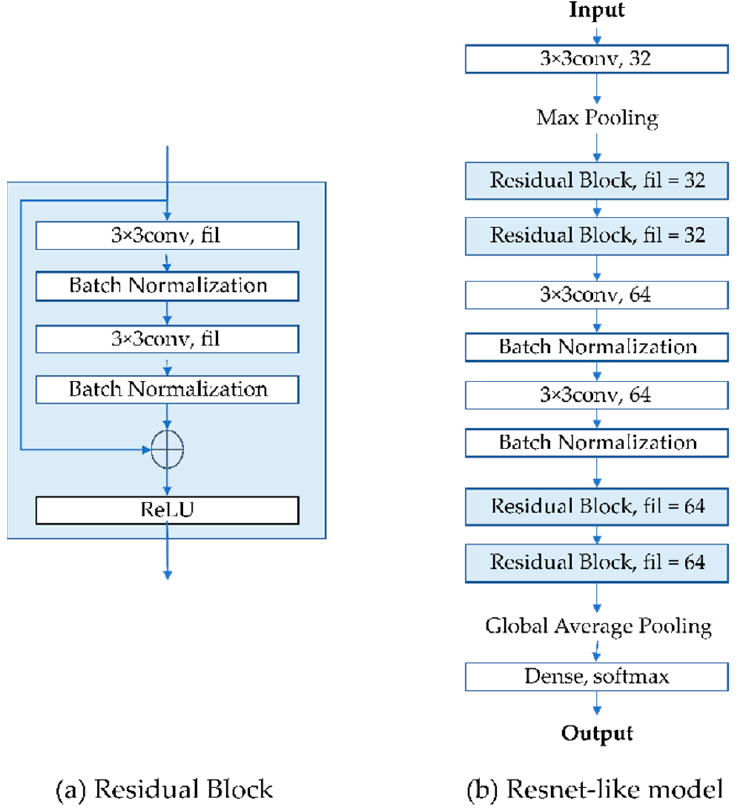
Figure 4. The ResNet-like model consists of twelve convolutional layers. ( a ) Residual block of the ResNet-like model with two convolutional and batch normalization layers, and ( b ) the whole structure of the ResNet-like model.